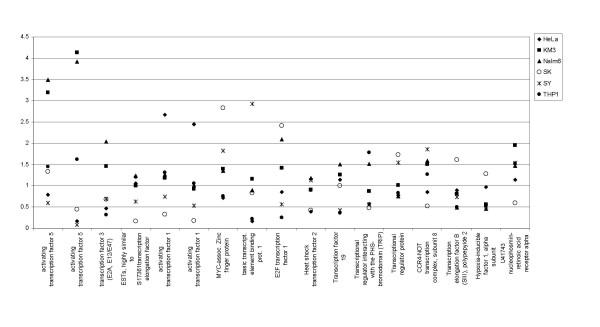
Neuroblastoma cells and lymphoma cells display specific differences in transcription factor expression. The diagram shows the  average expression levels of a set of transcription factors in the cell  lines analyzed by cDNA micro-arrays. The relative expression levels are  based on the comparison to a pooled human reference RNA.